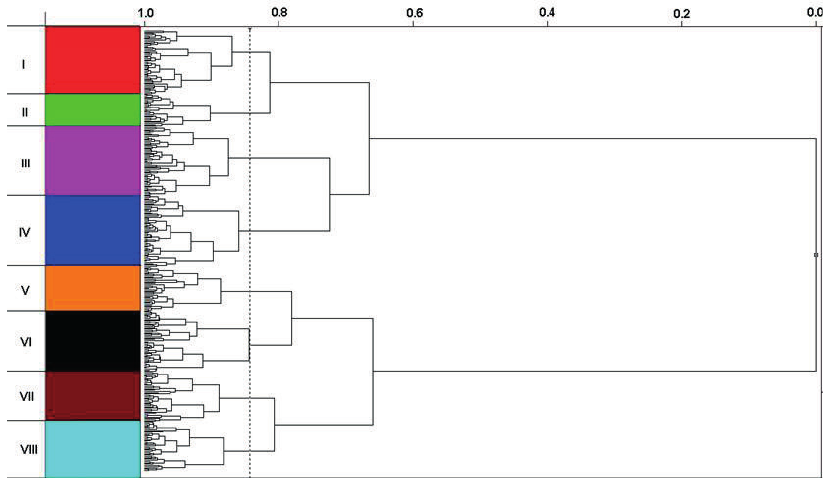
Figure 1 - Dendrogram obtained from the HCA using an X data matrix (347x6): Ward/ Incremental method and Euclidean distance. The dashed line indicates with 84.3% the similarity of the